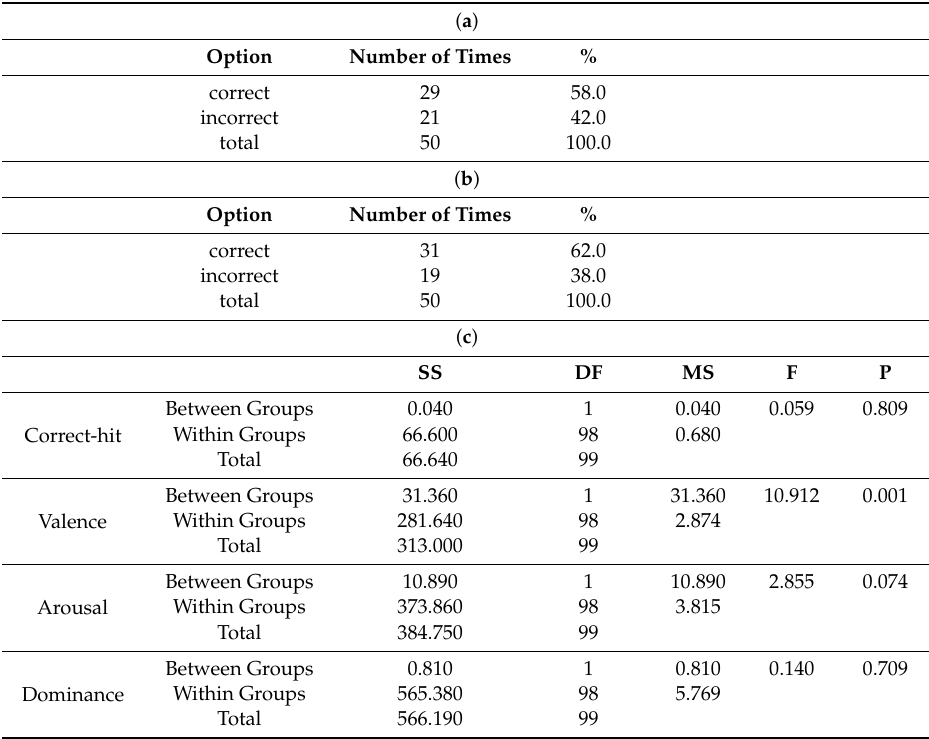
Table 5. ( a ) Usability assessment of the dirt-o ffl oading task with the physical product. ( b ) Usability assessment of the dirt-o ffl oading task with the virtual prototype. ( c ) ANOVA for usability assessment of the dirt-o ffl oading task.